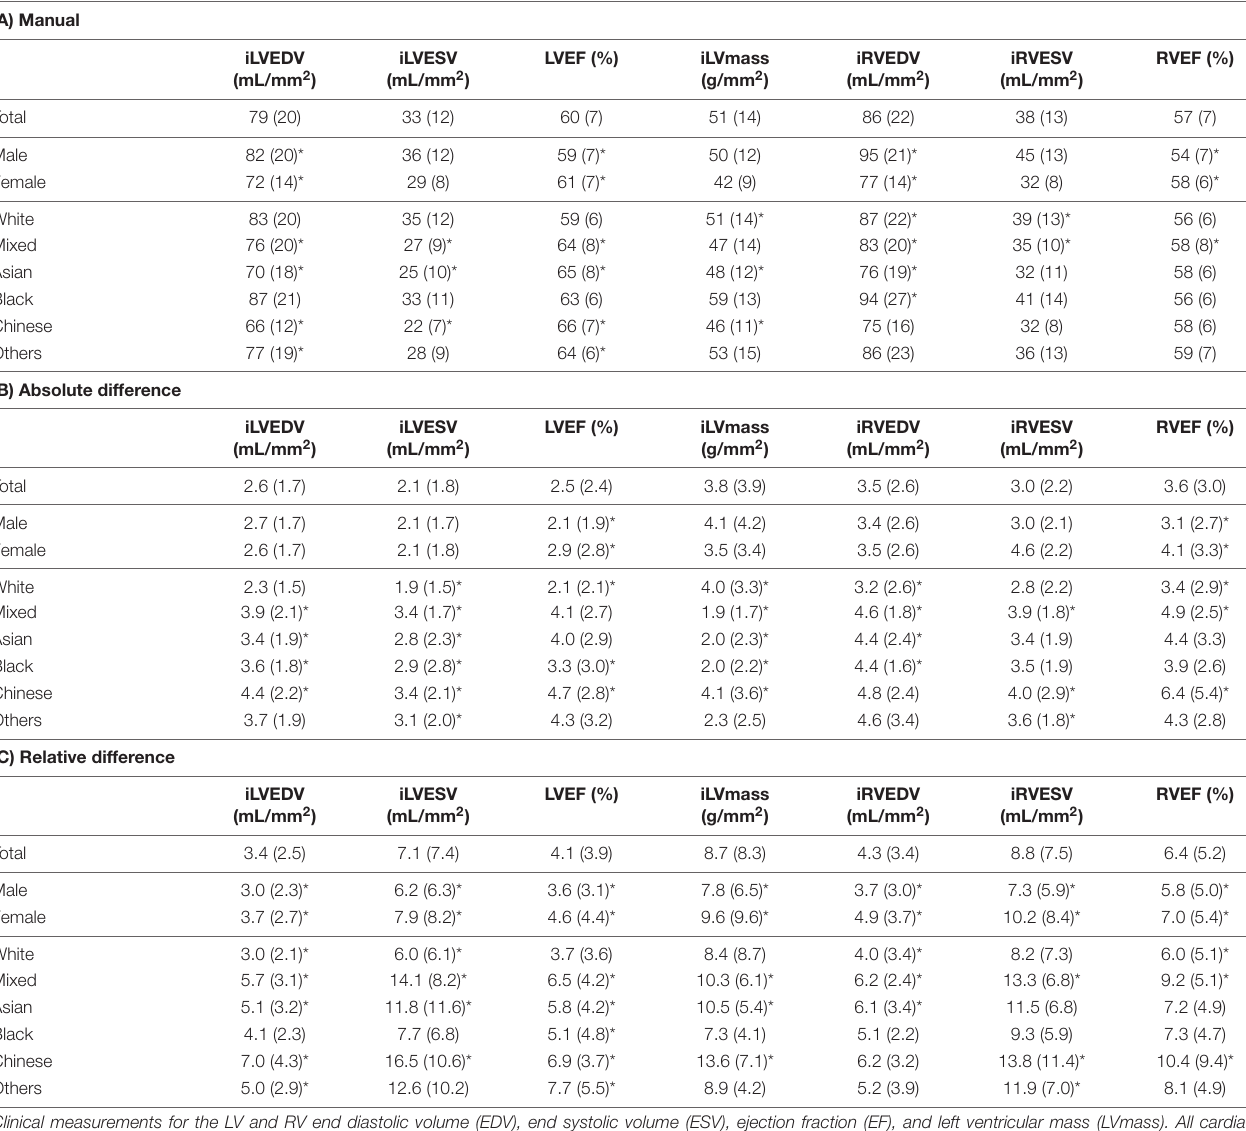
TABLE 3 | Manual clinical measurements (top table) and absolute (middle table) and relative (bottom table) differences in volumetric and functional measures between automated and manual segmentations, overall and by sex and